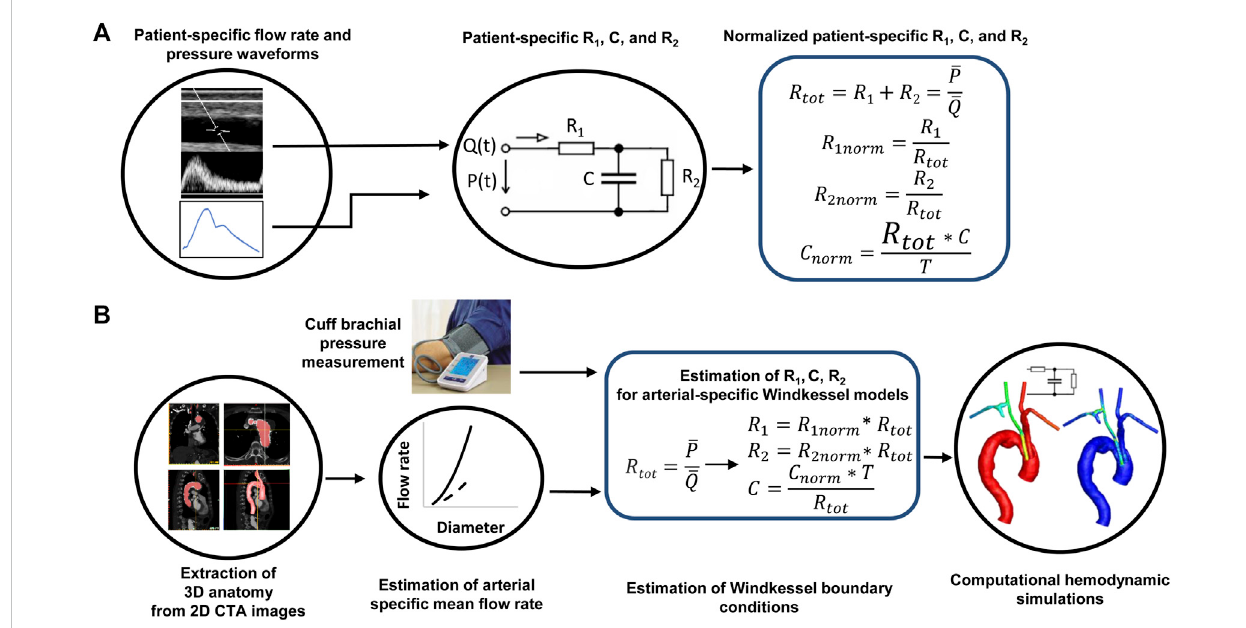
FIGURE 1 The pipeline of patient-speci fi c estimation of the parameters of a three-element Windkessel model when lacking patient-speci fi c fl ow rate and pressure waveforms. (A) Derivation of normalized Windkessel model parameters from patient-speci fi c fl ow rate and pressure waveforms. (B) Estimation ofWindkesselmodelparametersinformedbynon-invasivevascularimagingandpressuredata.R tot